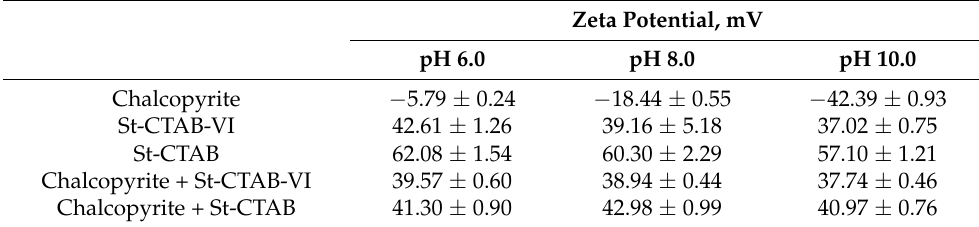
Table 5. Zeta potential measurements as a function of